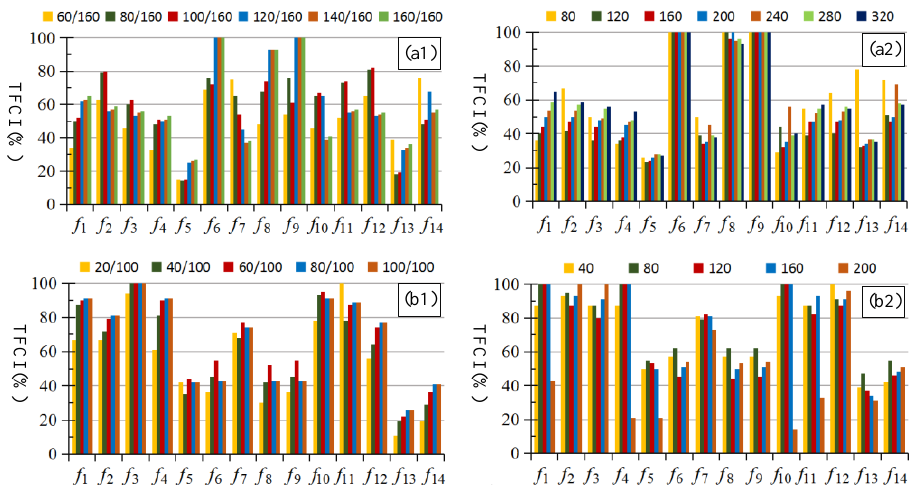
Figure 11. The results of TFCI values of cultivated land and forest with the different sample propor- tions and sizes. ( a1 , a2 ) are the results of TFCI values of cultivated land with the different sample proportions and sizes, respectively. ( b1 , b2 ) are the results of TFCI values of forest with the different sample proportions and sizes, respectively. Note: 60/160 denotes 60 cultivated land objects and 160 other types of surface objects which are included in the samples.